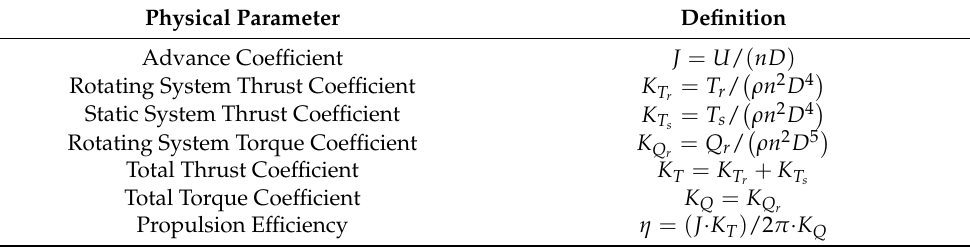
Table 1. Dimensionless expression of related physical parameters. Physical Parameter